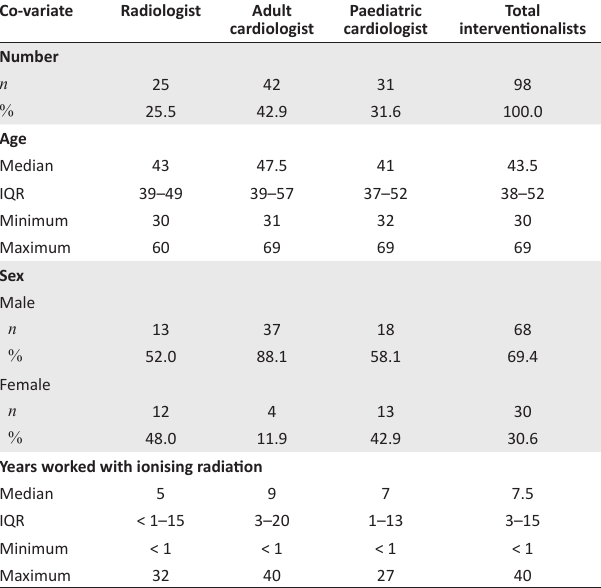
TABLE 1: Demographic details of 98 interventionalists. Co-variate